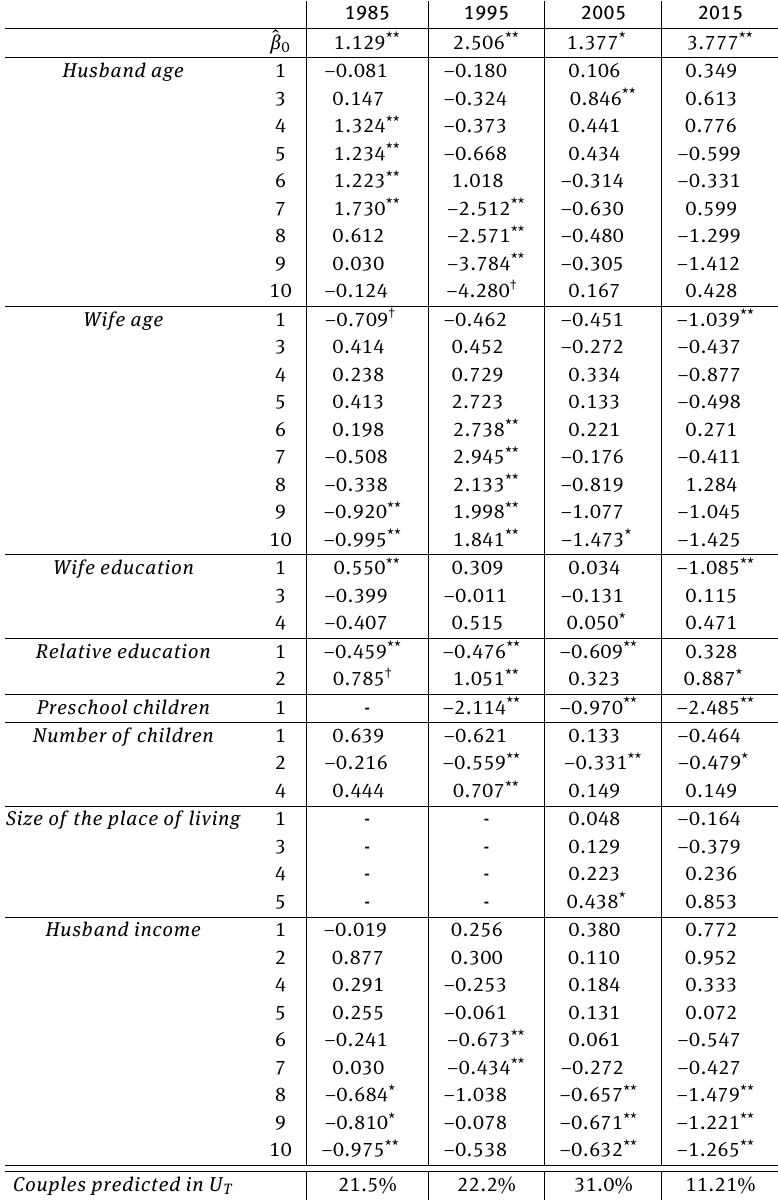
Table 6: Estimates of the regression parameters ( ˆ β ) for each wave and percentages of predicted couples in U T (categories are defined in Table